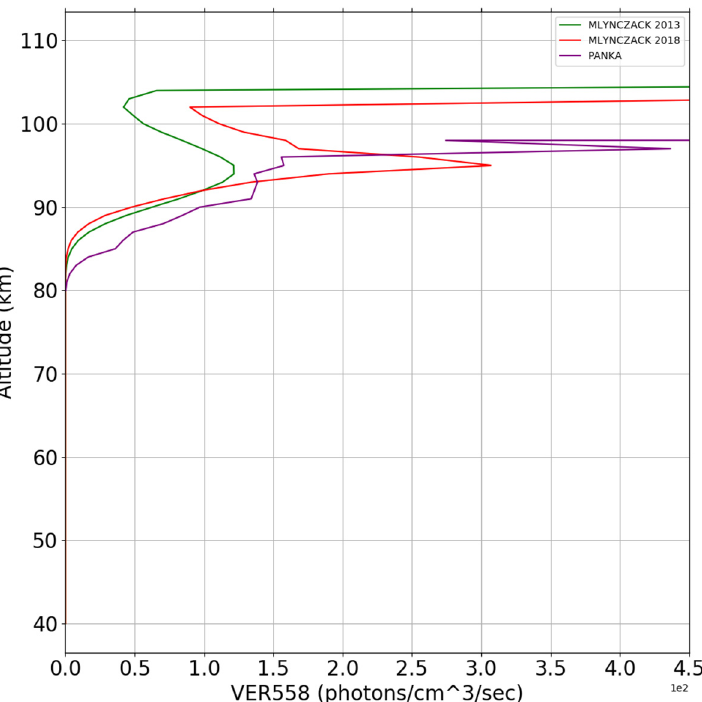
Figure 6. Height profiles of the 557.7 nm line airglow synthesized based on SABER data above GPO in Tory, nighttime. Integral over the entire time of observation. Green based on data calculated using [20], red line based on data calculated using [24], and magenta line based on data calculated using [25].